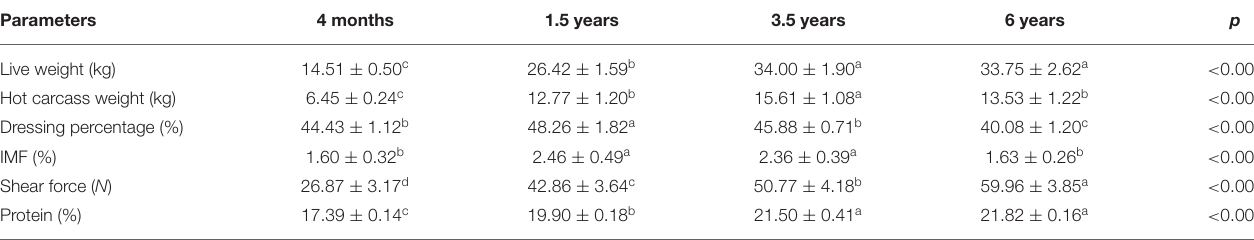
TABLE 1 | Carcass quality and meat quality of Tibetan sheep.